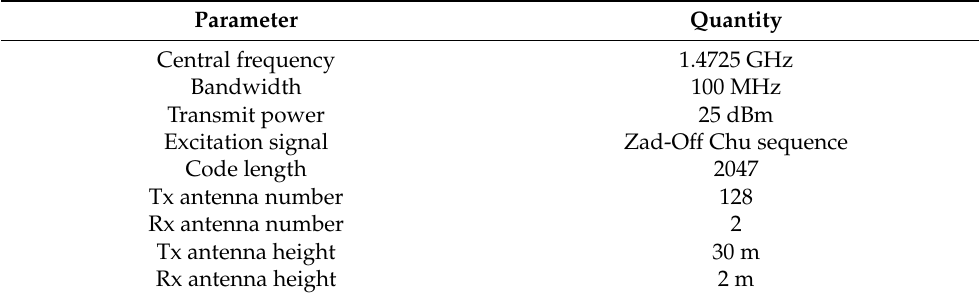
Table 1. Measurement system